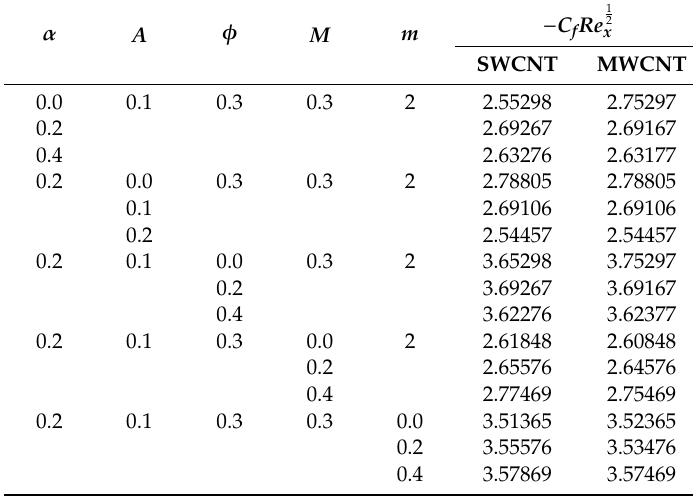
Table 3. Skin friction (wall drag)